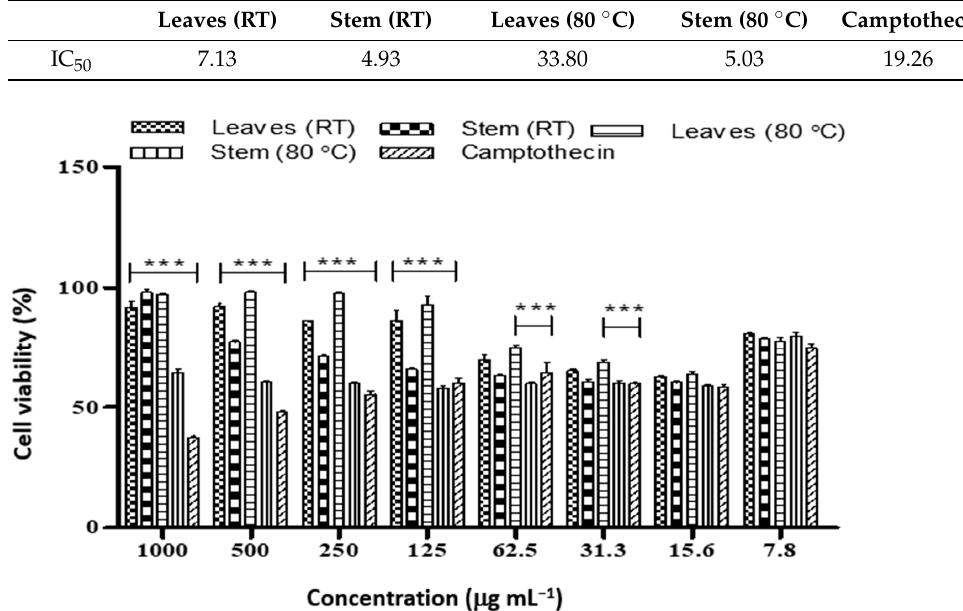
Figure 9. Cell viability of A549 cancer cell lines treated with different concentrations of nanoparticles synthesized from D. villosa leaves and stem extract at room temperature and 80 °C. *** (Leaves RT vs. Camptothecin), p < 0.001. *** (Leaves 80 °C vs. Camptothecin), p <